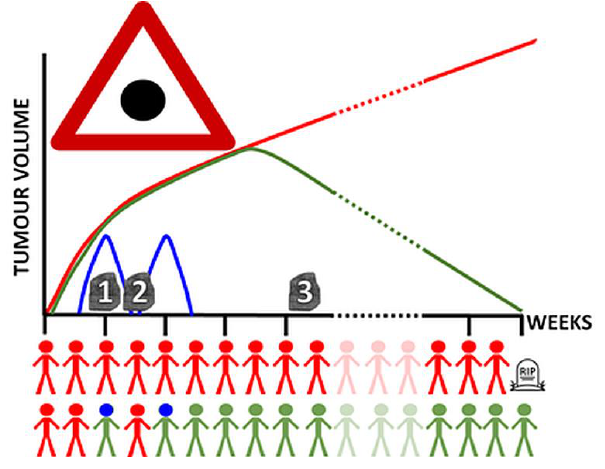
Figure 4. Our hypothesis in a graph. Patients that do not respond to therapy (red) will show a sustained increase in tumor volume with time. Patients that respond to therapy (green) will show a decrease in tumor volume at some timepoints, but before that, the immune system (blue curves) will have successfully attacked the tumor (indicated by the person with a blue head when the immune system activation is maximal). Note the period of one week of the blue curve. If we only measure tumor volume, we would be in a temporal blind spot (the red triangle with the black dot). Therefore, we should sample our biomarker at the precise time (1), since the wrong times (points 2 and 3) would be either uninformative or too late.